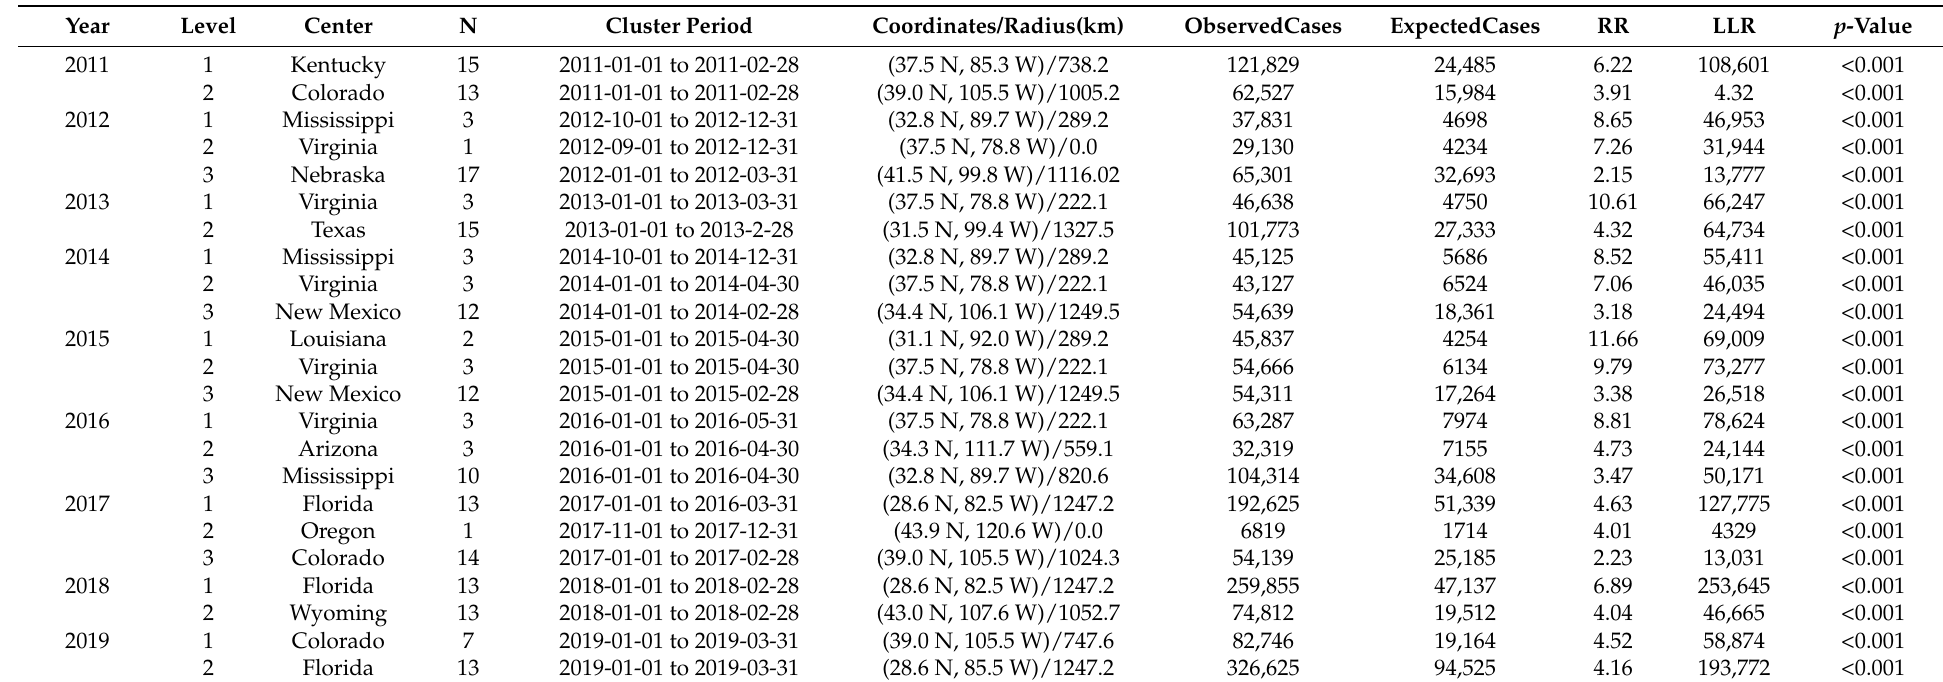
Table 2. Spatiotemporal scan of ILI in the United States from 2011 to